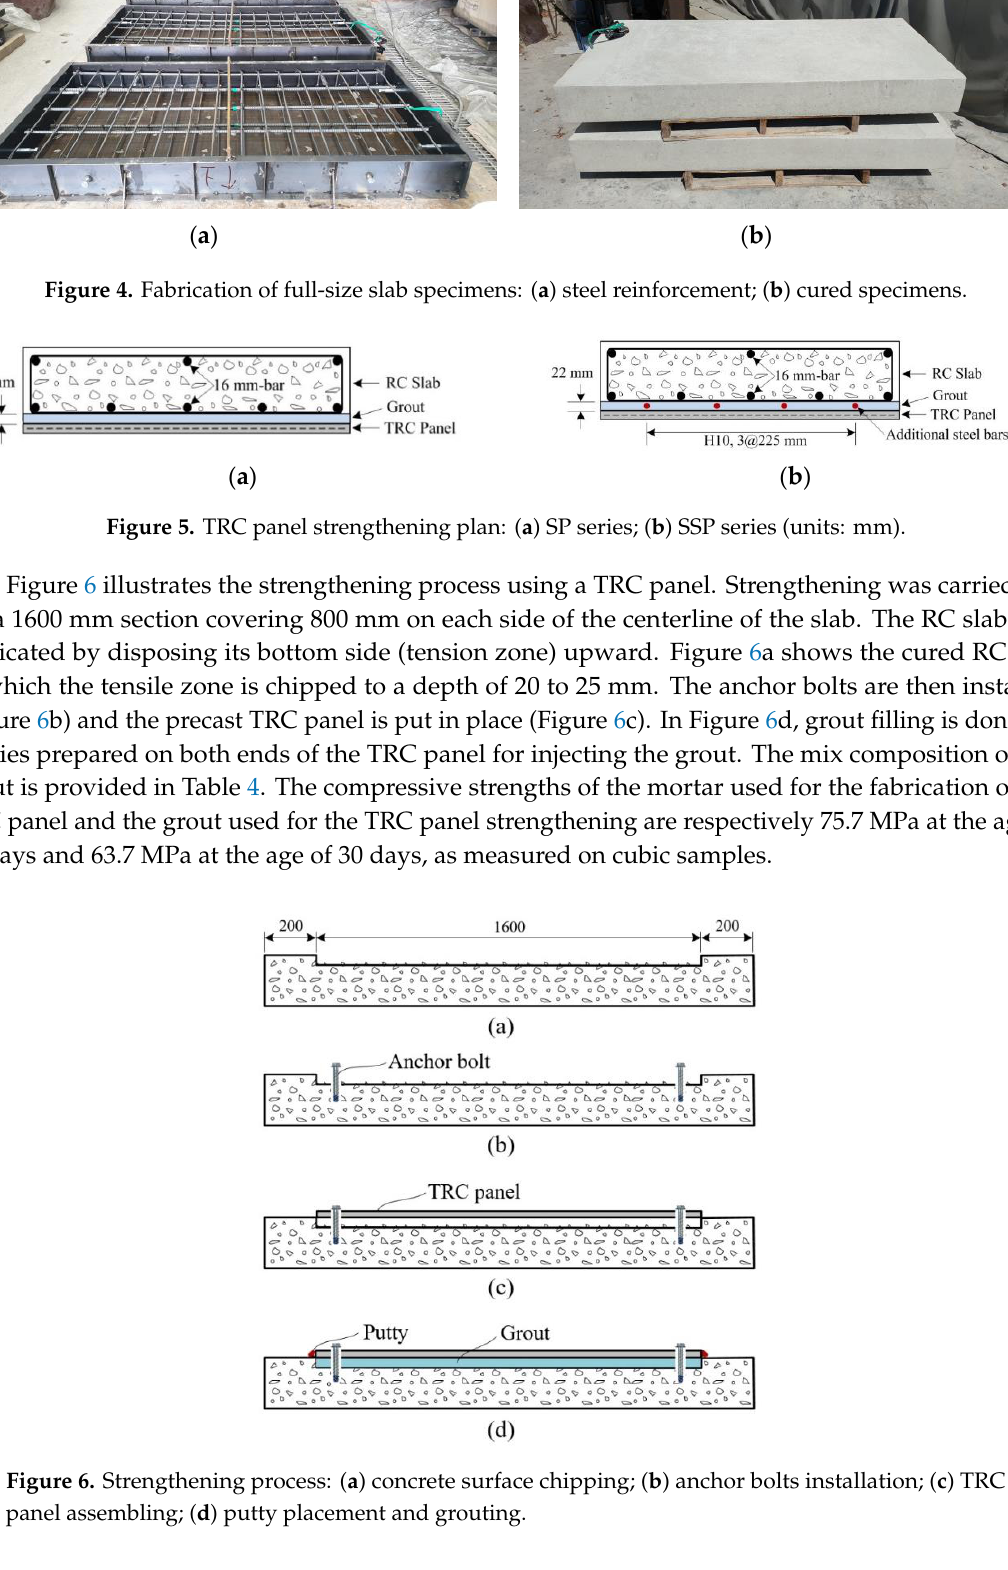
Figure 4. Fabrication of full-size slab specimens: ( a ) steel reinforcement; ( b ) cured specimens.